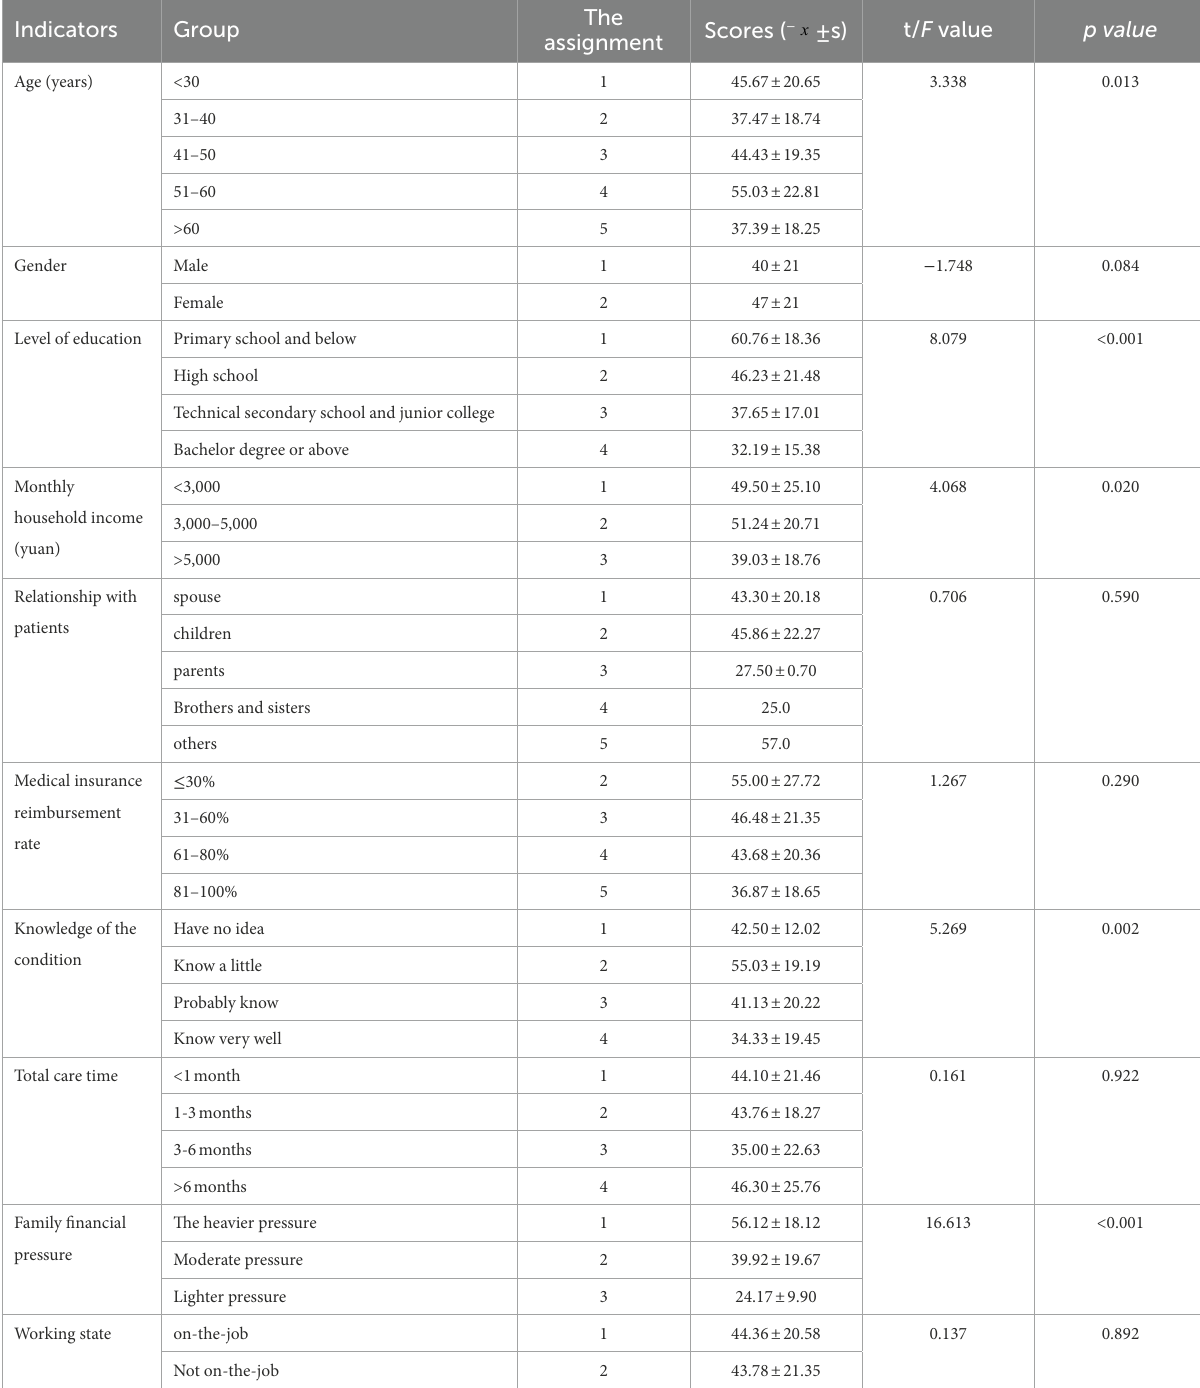
TABLE 2 Comparison of care burden scores of caregivers of pancreatic cancer patients with different characteristics